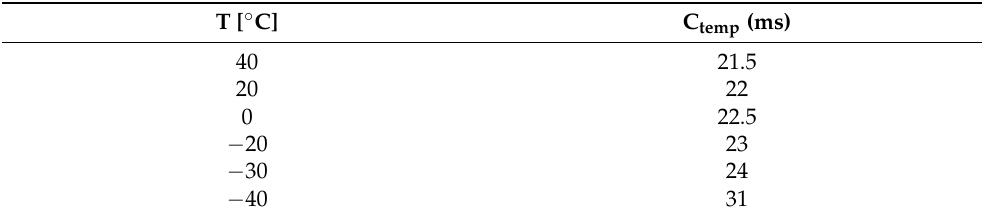
Table 2. Measured values of the dependency of time coefficient on outdoor temperature.